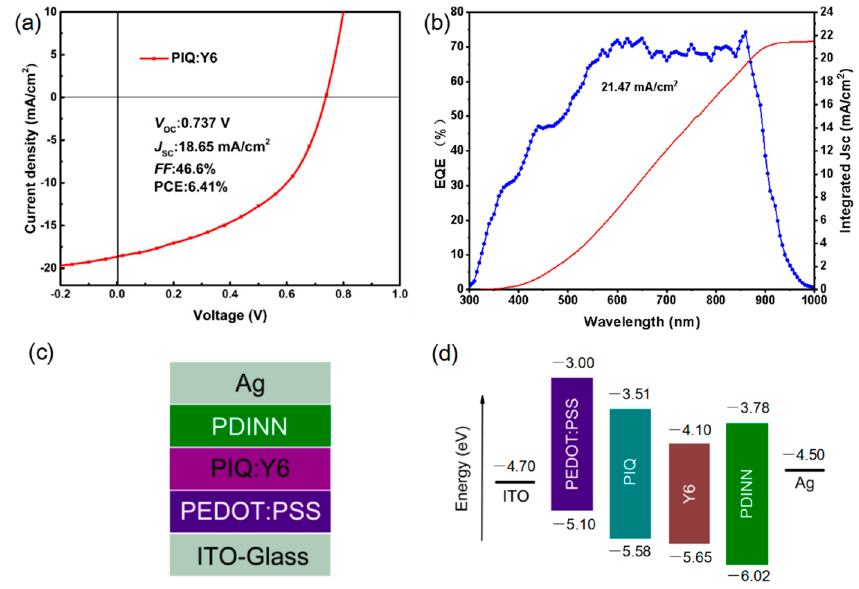
Figure 4. ( a ) J-V curve of the PIQ : Y6 blend-based polymer solar cells; ( b ) EQE spectrum of the PIQ: Y6 blend-based polymer solar cells; ( c ) schematic diagram of the device structure; ( d ) energy level diagram of the related materials.